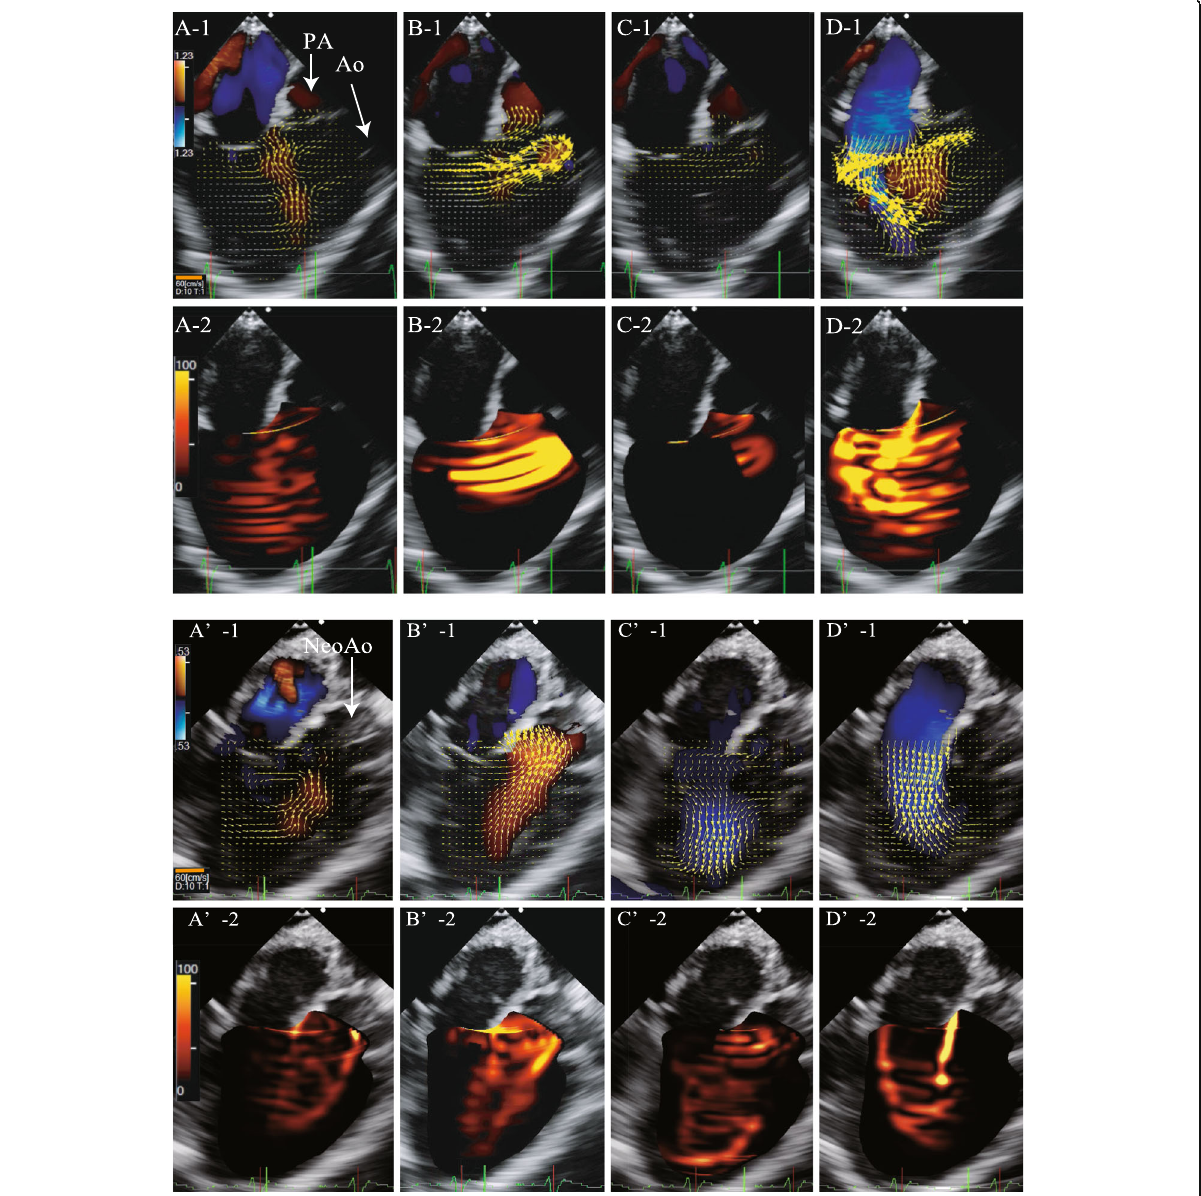
Fig. 2 Vector flow mapping by transesophageal echocardiography. Vector flow mapping (VFM) of the mid-esophageal long-axis view before (A – D) and after (A' – D') cardiopulmonary bypass. Brightness indicates high energy loss. After the surgery, EL decreased dramatically, especially in the diastolic phase. A,A ’ :isovolumic contraction phase. B,B ’ :systolic phase. C,C ’ :isovolumic relaxation phase. D,D ’ :Diastolic phase. -1: vector flow mapping image, orange line is scale bar of the vector. -2: Energy loss image. Abbreviations: Ao, aorta; EL, energy loss; Neo Ao, neo aorta;